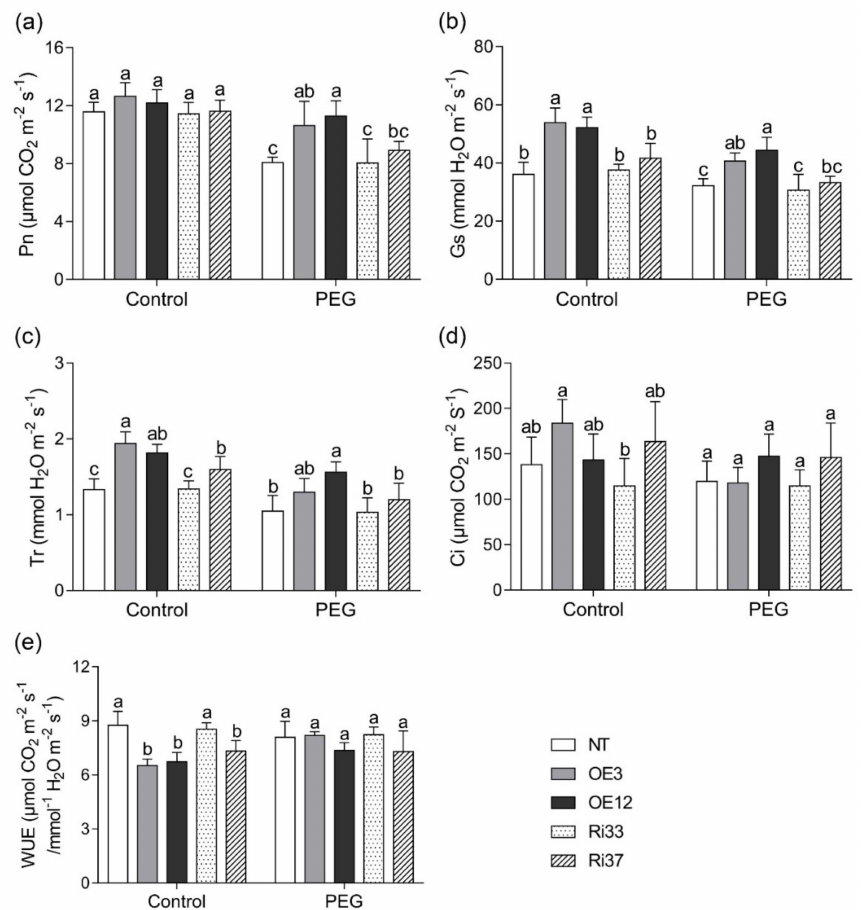
Figure 2. Effects of CgbHLH001 overexpression on gas exchange parameters of maize seedlings under drought stress. ( a ) Net photosynthetic rate (Pn); ( b ) stomatal conductance (Gs); ( c ) transpiration rate (Tr); ( d ) internal CO 2 concentration (Ci); ( e ) water use efficiency (WUE). NT, non-transgenic plant; OE3 and OE12, CgbHLH001 -overexpressed T 3 lines; Ri33 and Ri37, ZmbHLH -RNAi T 3 lines. PEG, 15% PEG 6000. Different lowercase letters above columns indicate significant differences between NT plants and transgenic lines under the same condition (Tukey’s test, p < 0.05). Values are means ± SD of three